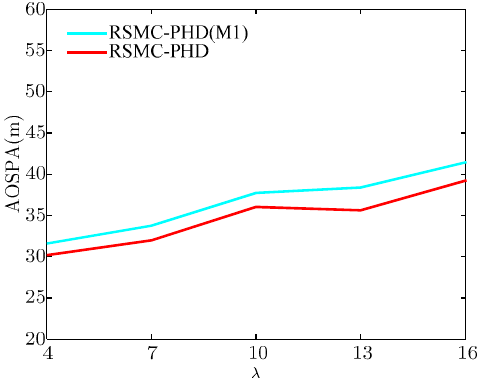
Figure 8. The estimate of AOSPA.